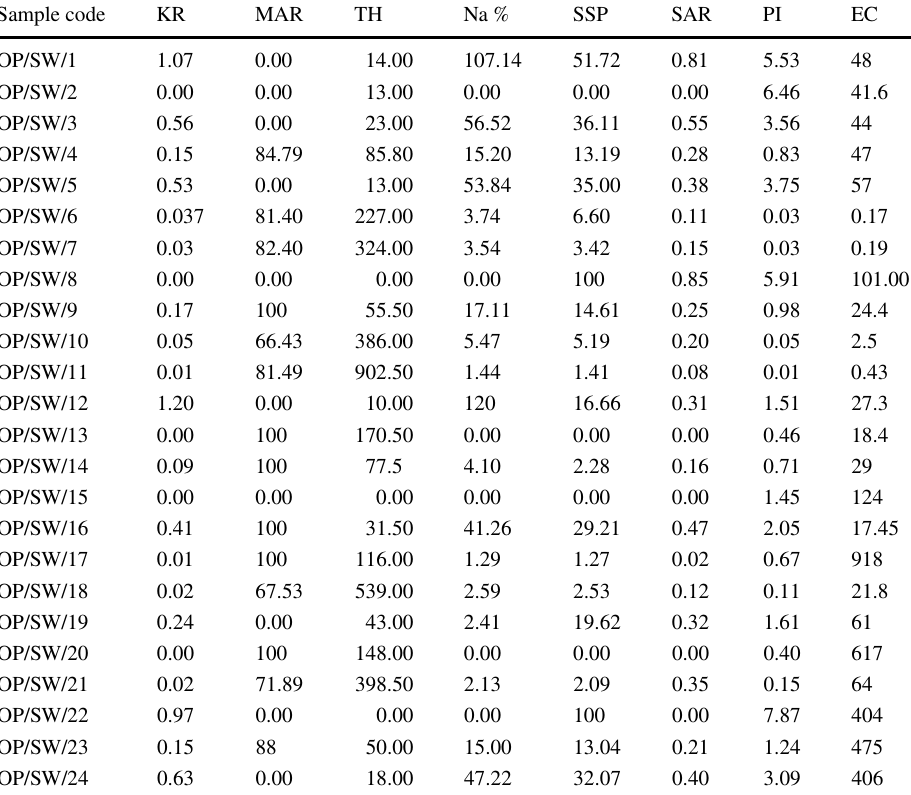
Table 3 Irrigation parameters for surface water in the Enyigba mining district